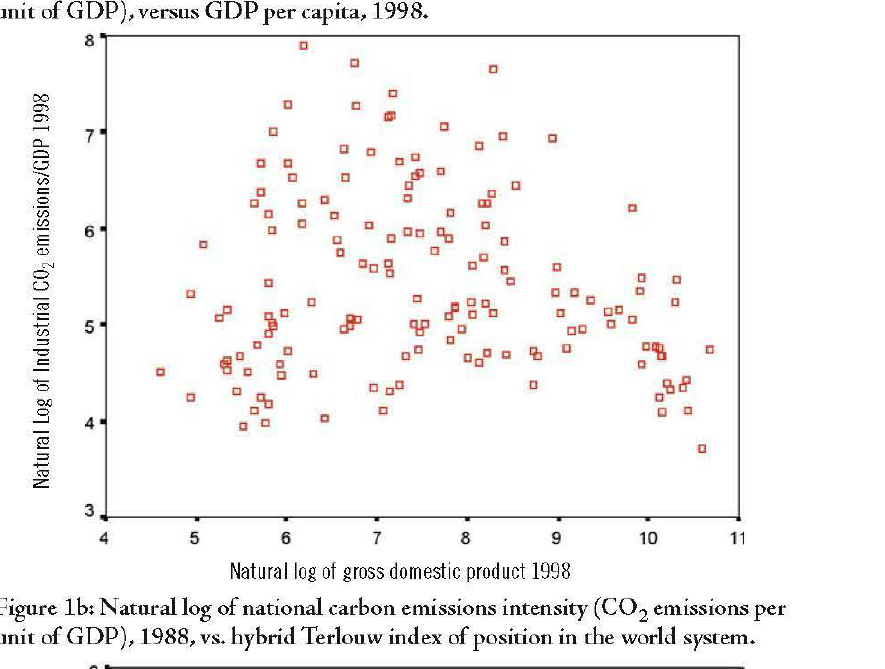
Figure l a: Natural log of national carbon emissions intensity (C0 unit of GDP), versus GDP per capita, 1998.